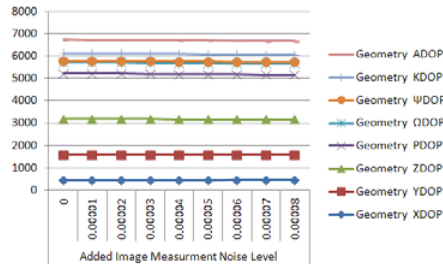
Figure 8. Geometric strength (DOP values in 6DOF) at different noise level